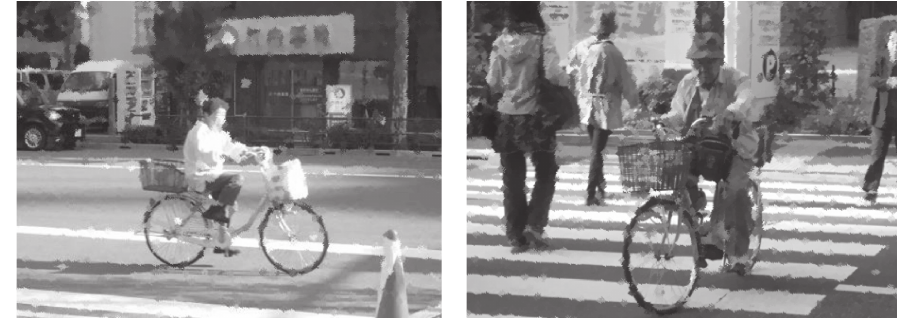
Figure 1. Elderly